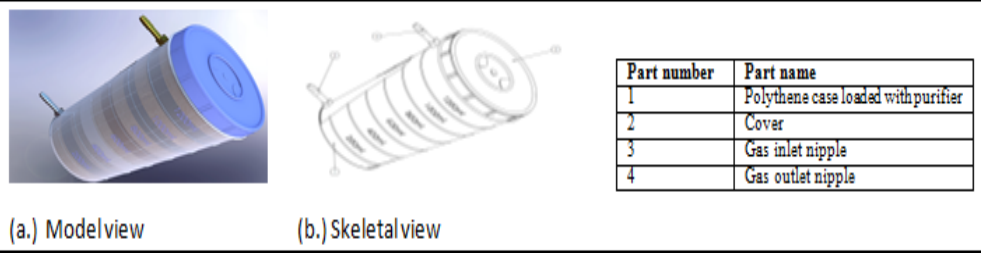
Fig. 1. Design concept one